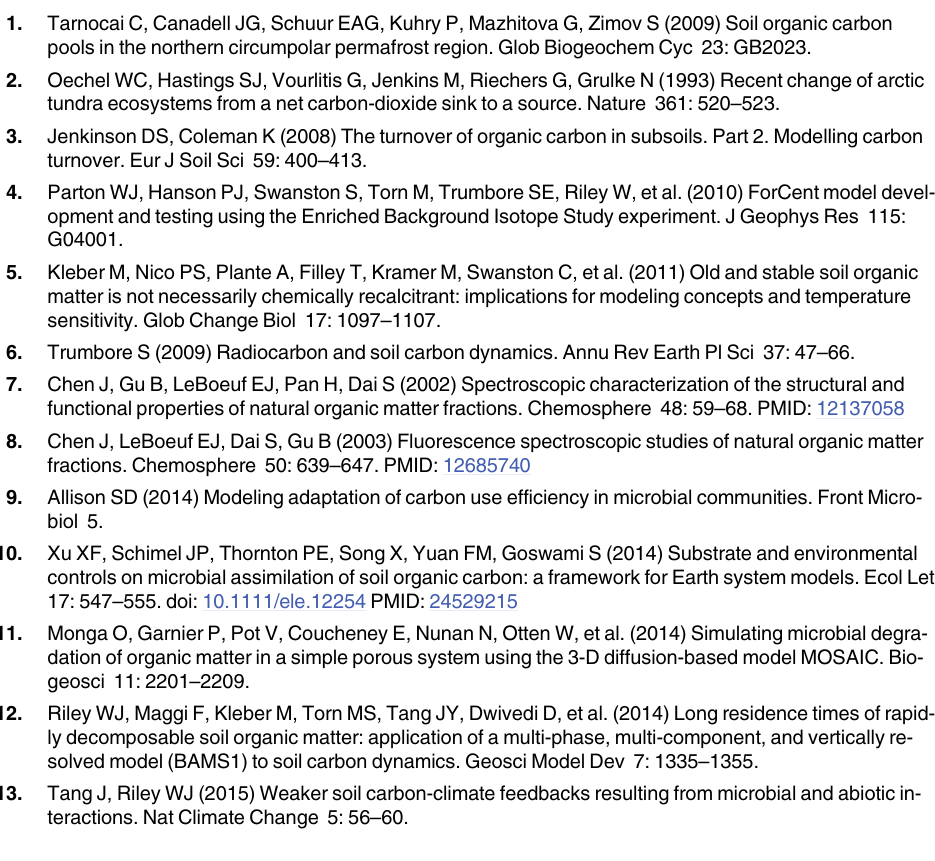
) and methane (CH )) during a 2 4